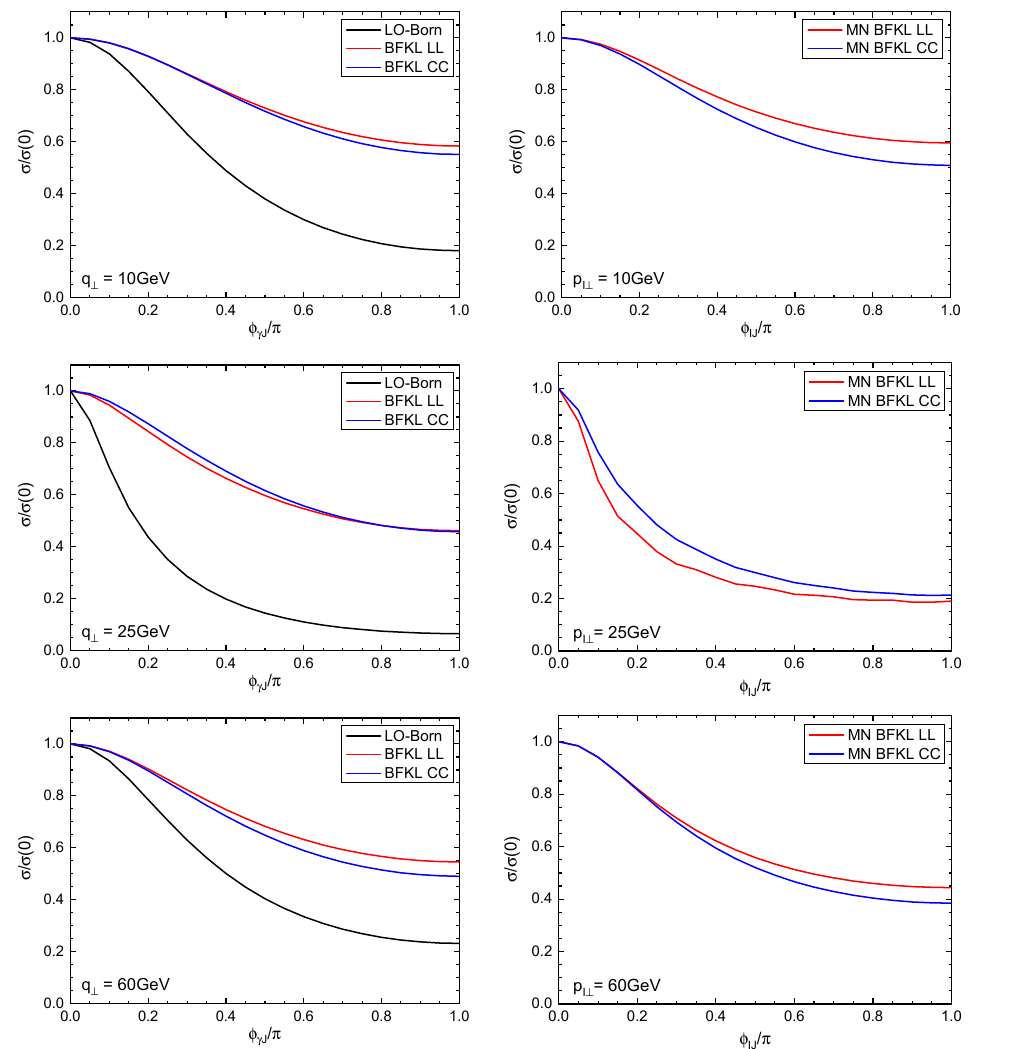
Figure 3 . The dependence on the azimuthal angle of the normalized helicity-inclusive cross section for the DY+jet (left column) and Mueller-Navelet jets (right column) productions. The following values of parameters are used: p J ? = 30 GeV, (cid:1) Y (cid:13)J = (cid:1) Y IJ = 7 and M = 35 GeV. The LO Mueller-Navelet distribution is not shown since d(cid:27) MN j LO = 0 when p I ? 6 = p J ? , see (4.3). Angles (cid:30) (cid:13)J and (cid:30) IJ are de(cid:12)ned such that they equal zero for con(cid:12)gurations